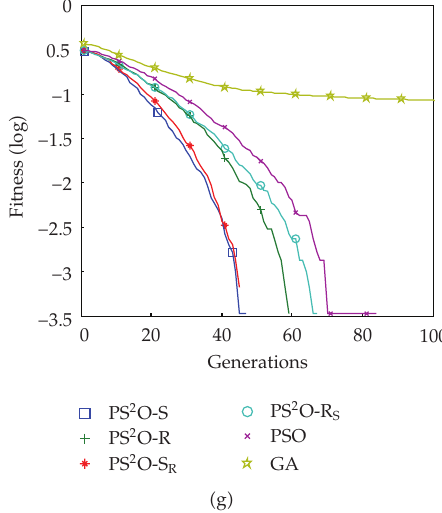
Figure 11: The median results of discrete functions. (cid:2) a (cid:3) Goldberg’s order-3. (cid:2) b (cid:3) Bipolar order-6. (cid:2) c (cid:3) Mulenbein’s order-5. (cid:2) d (cid:3) Clerc’s Zebra-3. The median convergence results of discrete functions. (cid:2) e (cid:3) Clerc’s order-3 problem 1. (cid:2) f (cid:3) Clerc’s order-3 problem 2. (cid:2) g (cid:3) Discrete multimodal